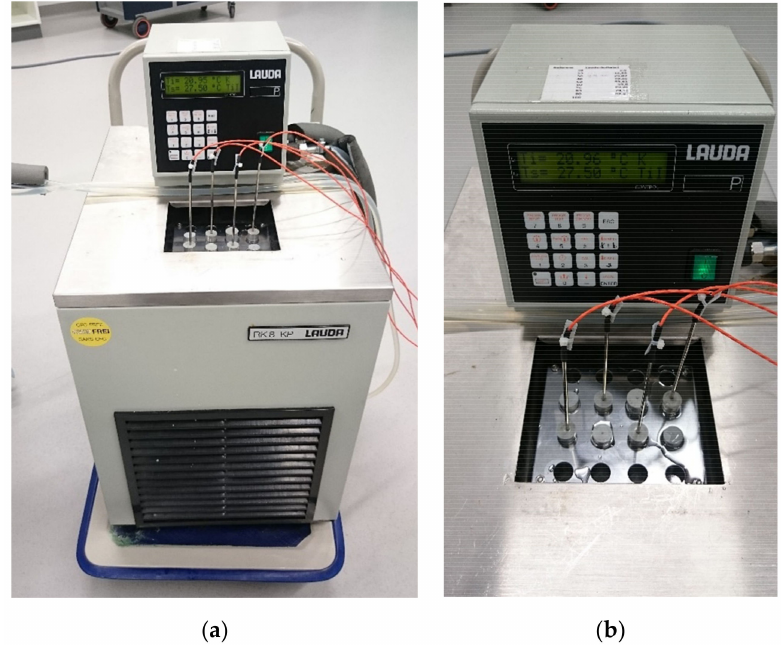
Figure 15. View of the stability testing device “LTTT” ( a ) and detailed view of the arrangement of the sample holders ( b ).